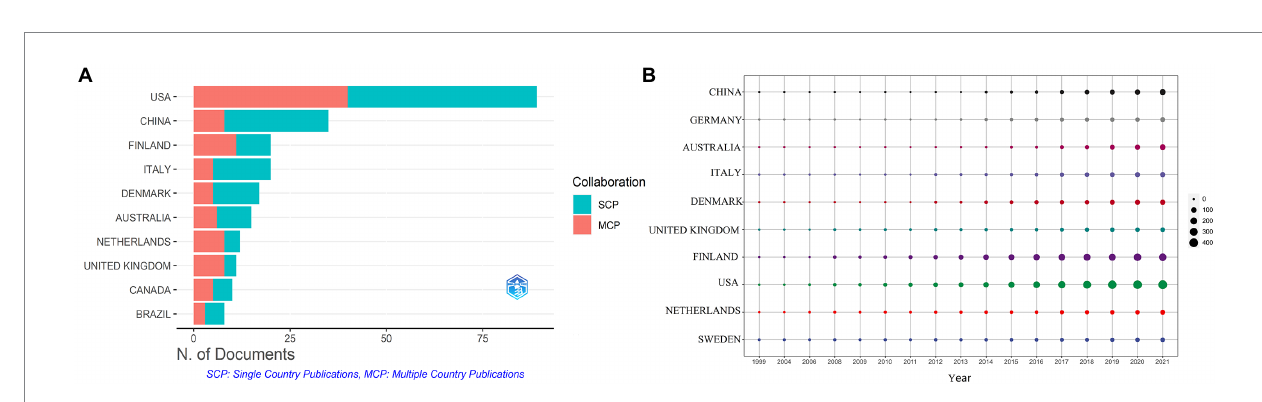
FIGURE 4 (A) Publication partnerships. (B) Annual contributions of the top 10